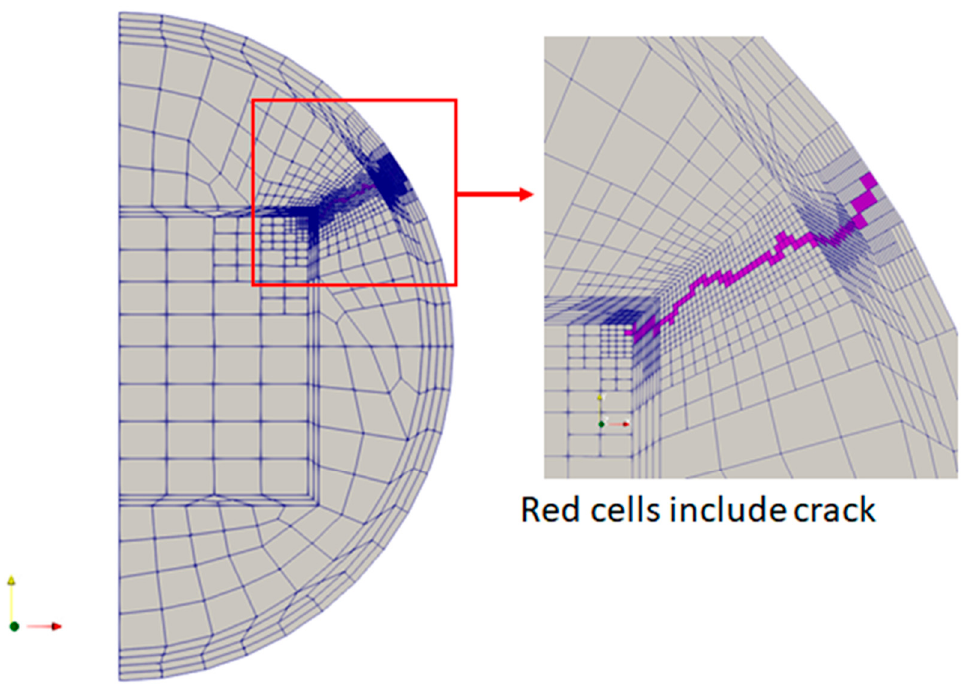
Figure 15. GARFIELD-CHEM refined mesh after cracking.